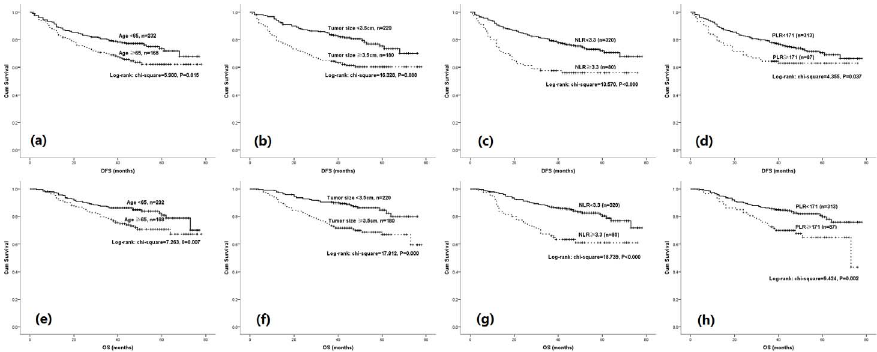
Figure 1. Kaplan-Meier estimates according to categorical age, tumor size, NLR and PLR on DFS (a, b, c, d) and OS (e, f, g, h).